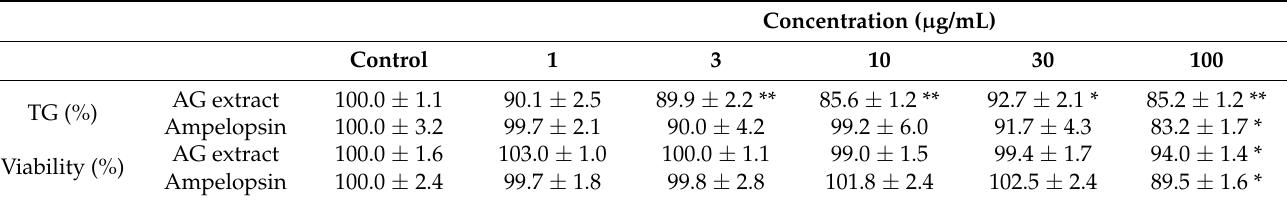
Table 3. TG contents and viability of 3T3-L1 cells treated with AG extract and ampelopsin.